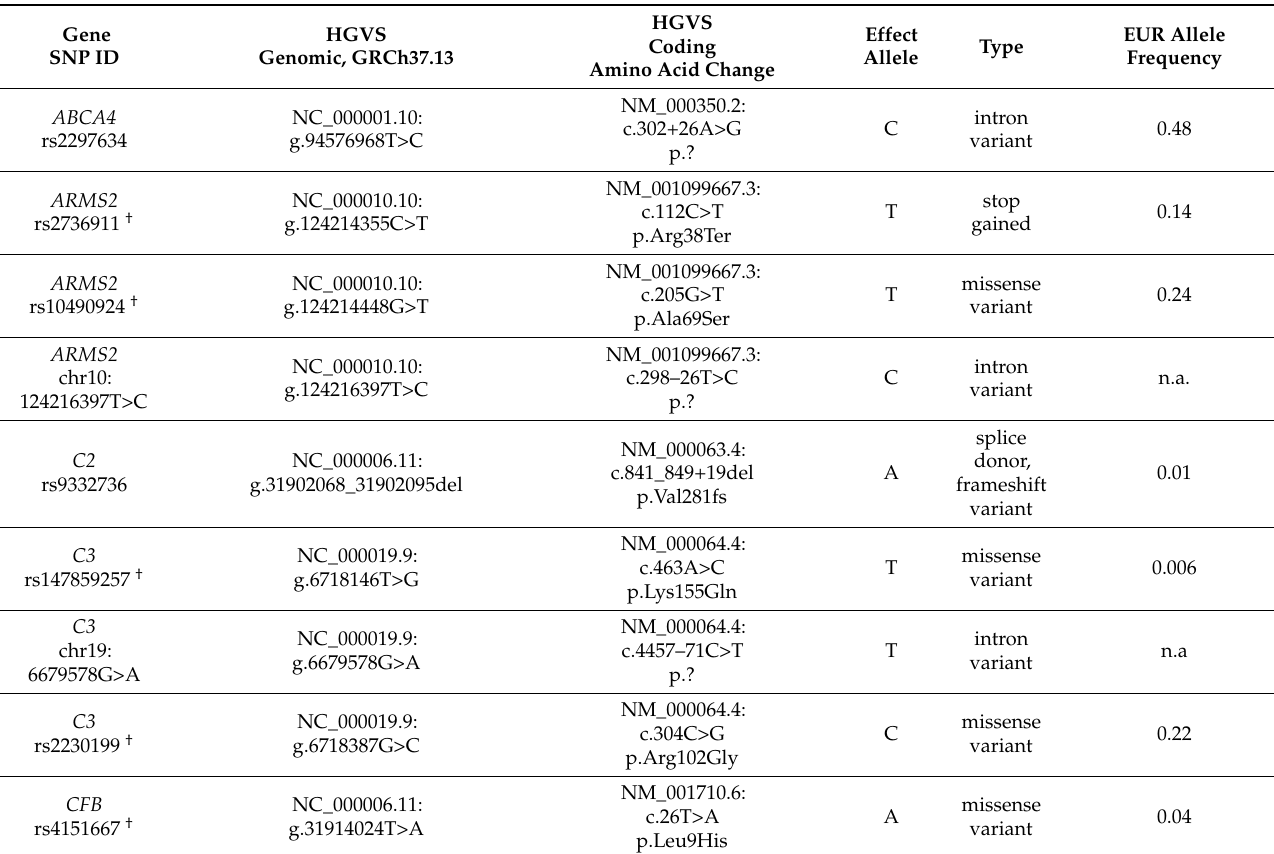
Table 4. Variants with a p -value lower than threshold P T = 0.0123 included in PRS model. (†) variants previously reported in studies on AMD. (?) unknown effect on protein, according to HGVS